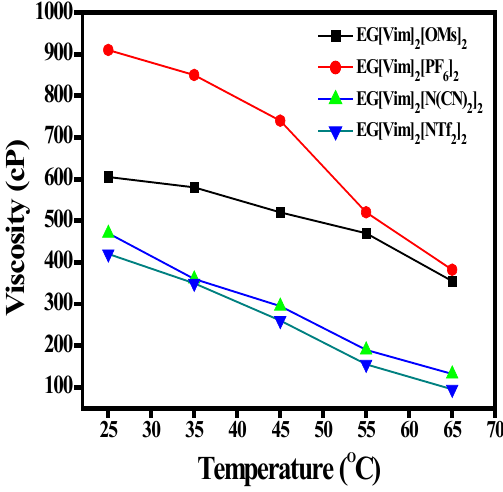
Figure 3: Viscosity of synthesized di-cationic RTILs at different